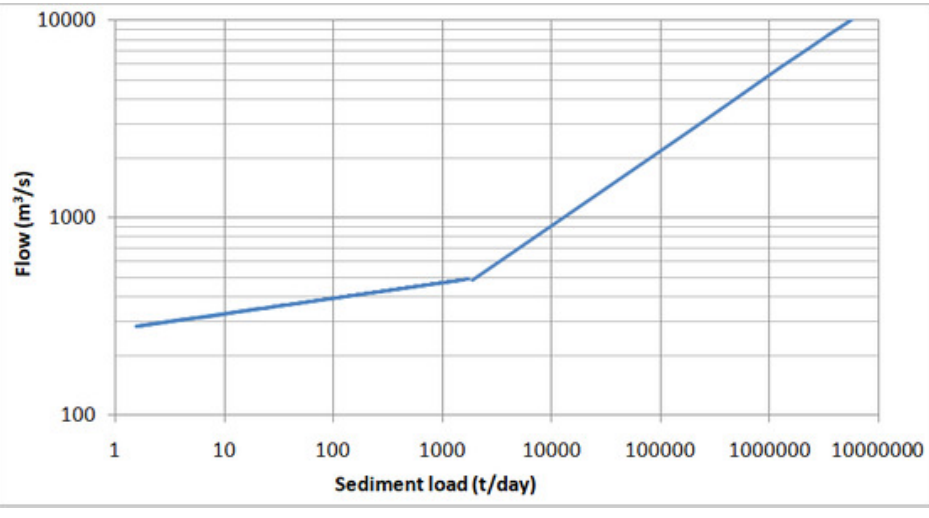
Figure 4. Sediment rating